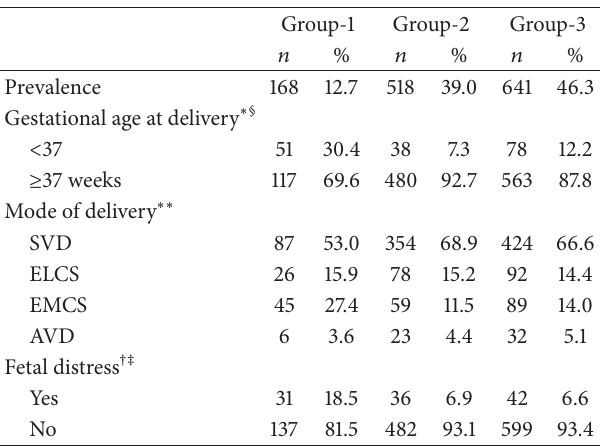
Table 1: Prevalence, gestational age at delivery, mode of delivery, and occurrence fetal distress in labour among the study groups (Group-1: SGA according only to Bangladeshi growth chart; Group- 2: SGA according to European grow chart and AGA according to Bangladeshi growth chart; Group-3: AGA according to both growth